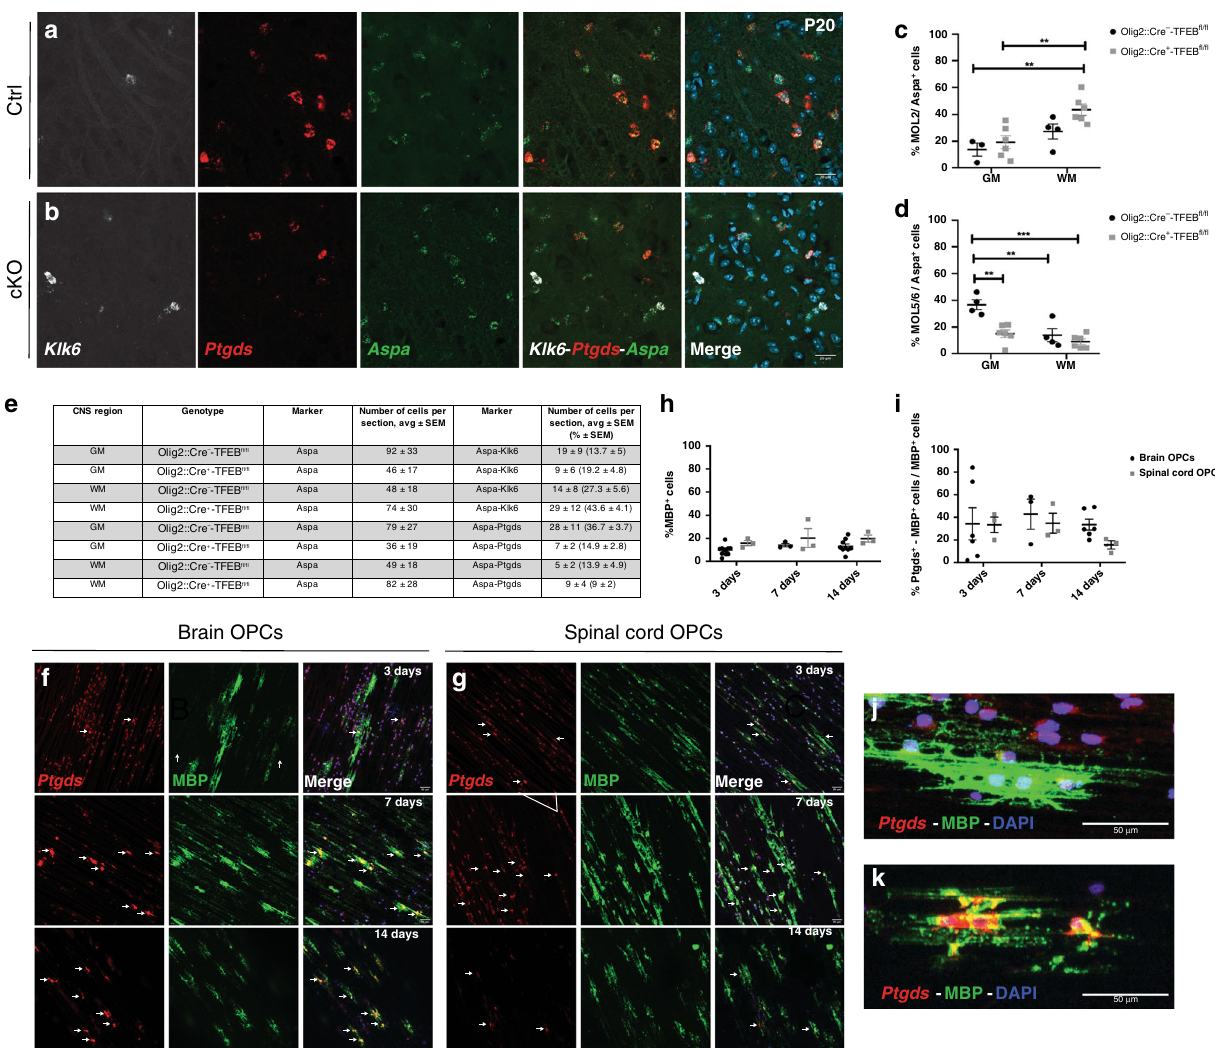
Fig. 4 TFEB does not regulate OPC differentiation into distinct MOL subpopulations during development and the OL lineage heterogeneity observed in vivo is not modeled in 3D culture conditions. a , b Confocal representative images show that MOL2 ( Klk6 + - Aspa + cells) and MOL5/6 ( Ptgds + -Aspa +